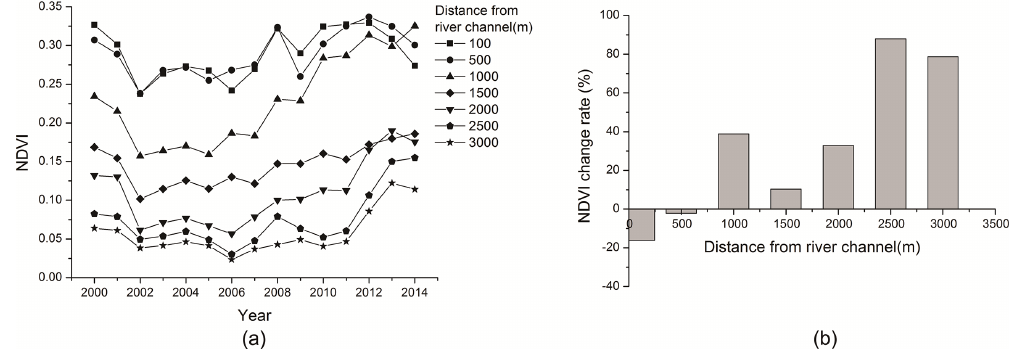
Figure 5. The temporal variation of NDVI (a) and annual variability of NDVI (b) from 2000 to 2014 at different distances from the river channel.